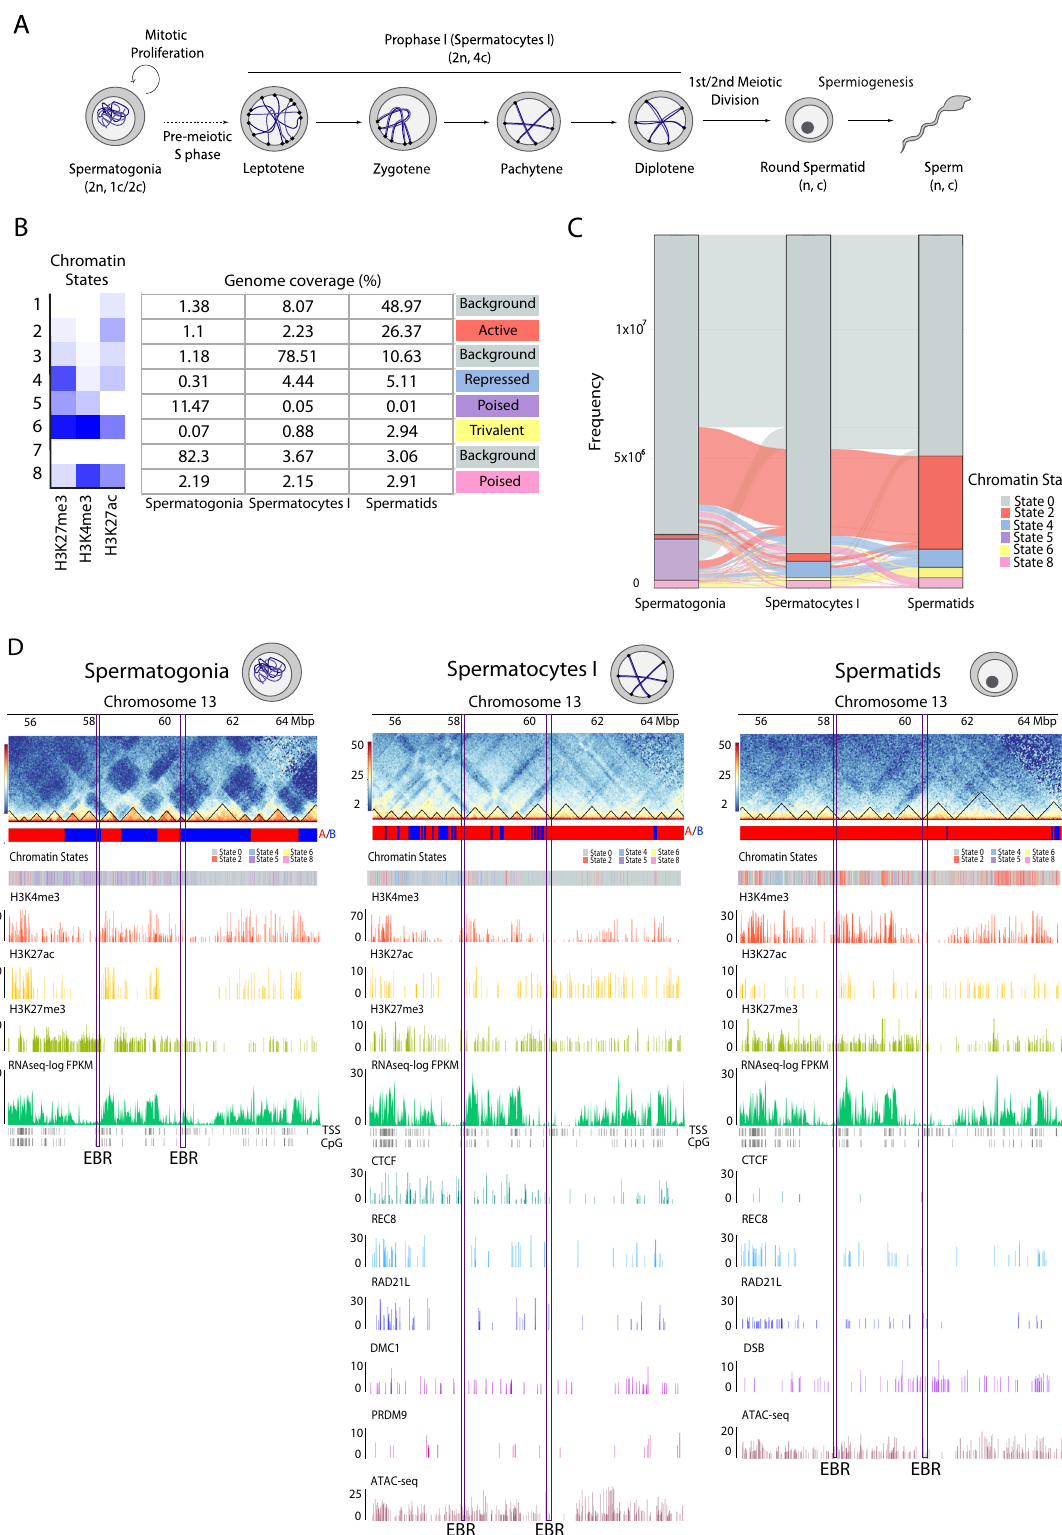
associated with TAD boundaries in spermatogonia and sperma- spermatids (Fig. 3B and Supplementary Fig 7). Consistent with tocytes, but located within TADs in round spermatids (Fig. 3B this, EBRs are associated with ‘ closed ’ chromatin environments and Supplementary Fig 7). Although EBRs were associated with (E0, E4, E5) in spermatogonia and ‘ open ’ chromatin environ- TSS, these regions do not present high levels of expression in ments (E2, E6, E8) in both primary spermatocytes and round spermatogonia but are expressed more highly in round spermatids. At a fi ner structural level, too, EBRs are associated spermatids (Mann – Whitney test, p < 2.2e − 16) (Supplementary with regions that undergo structural remodelling, being NATURE COMMUNICATIONS| (2022) 13:2608